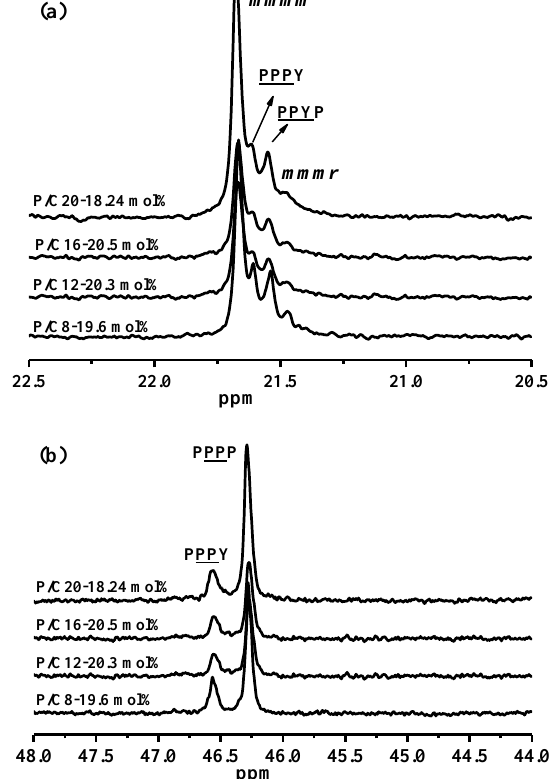
Figure 2. 13 C NMR spectra of the methyl region ( a ) and the methylene region ( b ) of propylene-based elastomers produced by dimethyl (pyridyl-amino) hafnium catalyst.